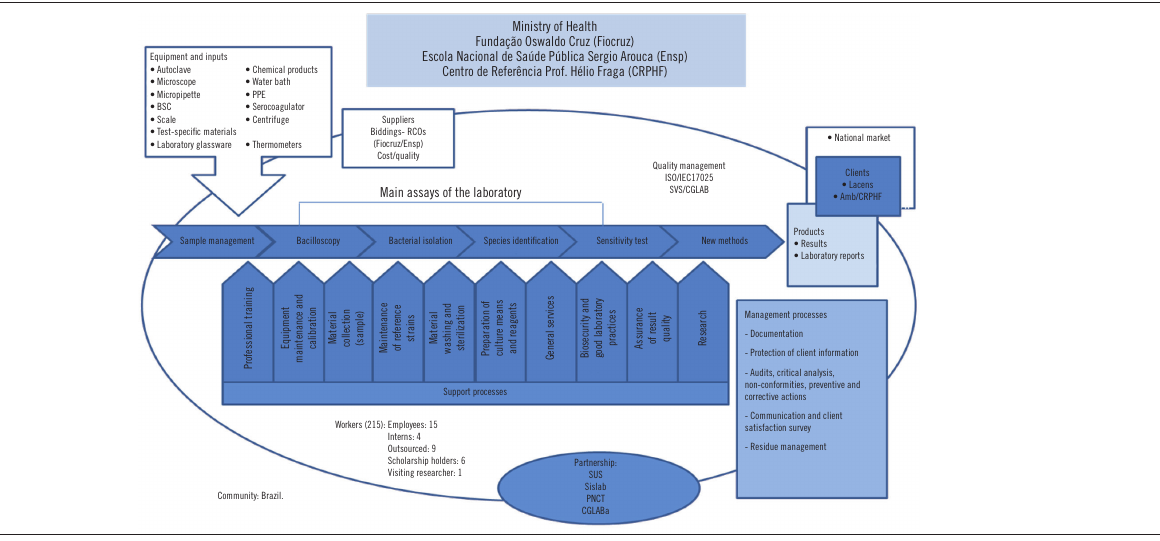
figurE 2 – Enterprise profile